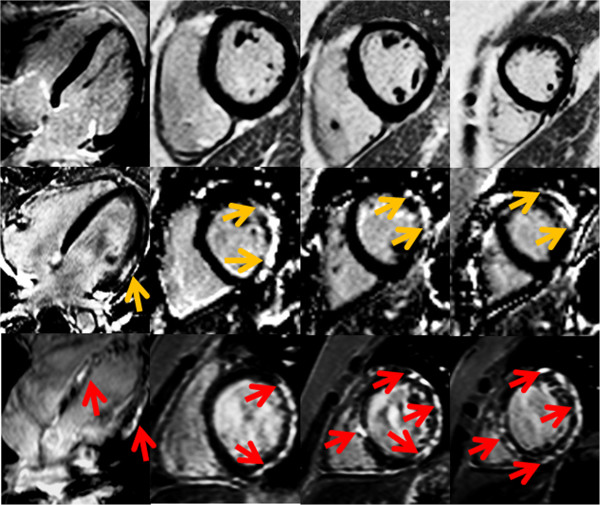
Examples of LGE by CMR. (Top Panel) 12 year old DMD patient with no LGE (dark myocardium), (Middle Panel) 8.5 year old DMD patient with LGE in the free wall only (bright areas shown by yellow arrows) and (Bottom Panel) 18 year old DMD patient LGE involving multiple segments including the septum (bright areas shown by red arrows).